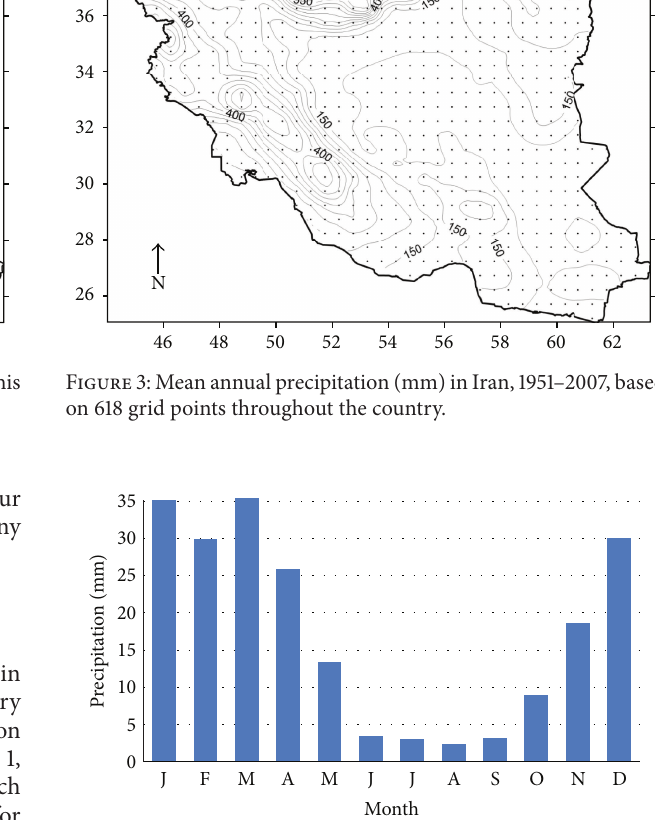
Figure 4: Average monthly precipitation (mm) for 618 grid points in Iran,